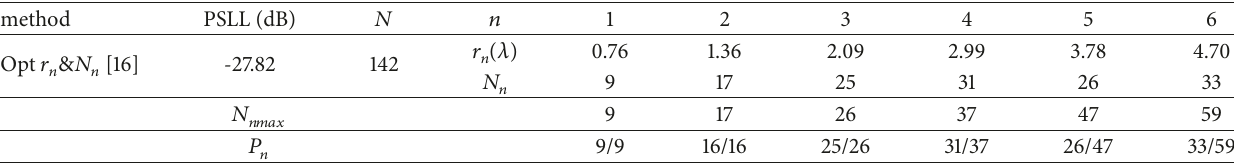
Table 1: The fitting data: element number ( 𝑁 ), ring radii ( 𝑟 𝑛 (𝜆) ), actual element number in the rings ( 𝑁 𝑛 ), maximum element number ( 𝑁 𝑛𝑚𝑎𝑥 ) , and element retention rate ( 𝑃 𝑛 ).